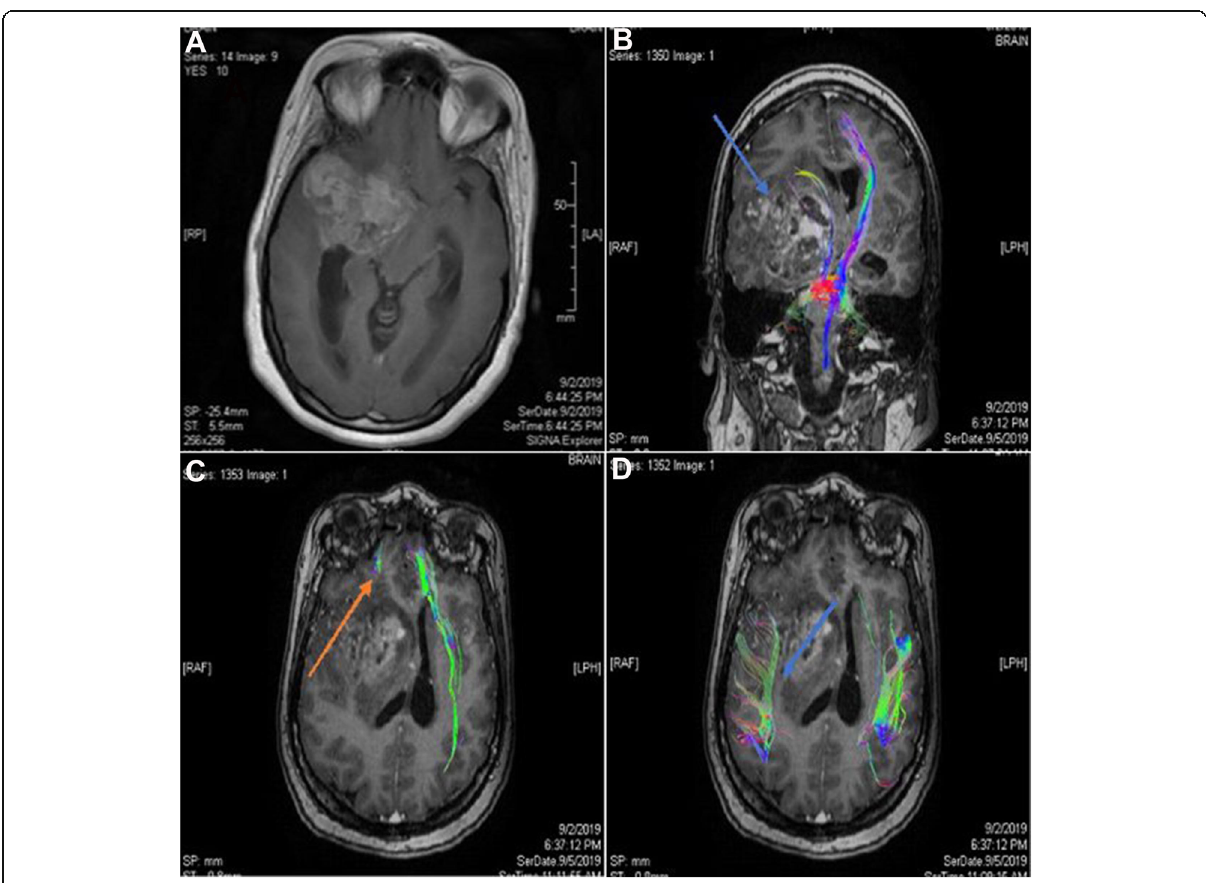
Fig. 3 Case number 2. A 42-year-old woman with a right temporo-frontal, high-grade gliosarcoma, preoperative radiological examination. a Axial T1 WI with contrast revealing heterogeneous post-contrast enhancement surrounded by grade II vasogenic edema. b Coronal T1 WI with 3D reconstruction of the corticospinal (CST) tracts showing pattern IV inward displacement, attenuation, and fiber destructions of the right CST (blue arrow) compared to intact left CST. c Sagittal T1 WI with 3D reconstruction of the inferior longitudinal fasciculus (ILF) and part of uncinate fasciculus tracts showing pattern V destruction of the tracts on right side (orange arrow). d Sagittal T1 WI with 3D reconstruction of the superior longitudinal fasciculus (SLF; blue arrow) showing pattern II mild decreased FA, yet no fibers displacement on the right side